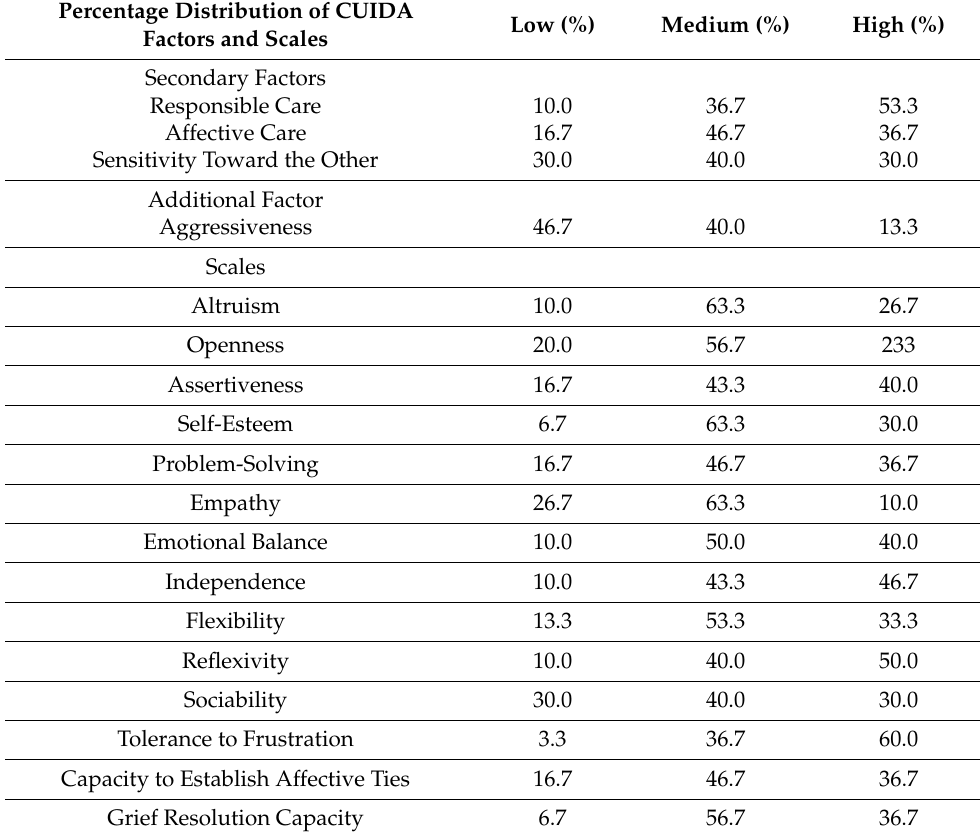
Table 2. Percentage distribution of CUIDA factors and scales (Cuestionario para la Evaluaci ó n de Adoptantes, Cuidadores, Tutores y Mediadores, Eng. Tr. Questionnaire to evaluate people taking care of others, guardians and mediators [43], Italian adaptation [44]).